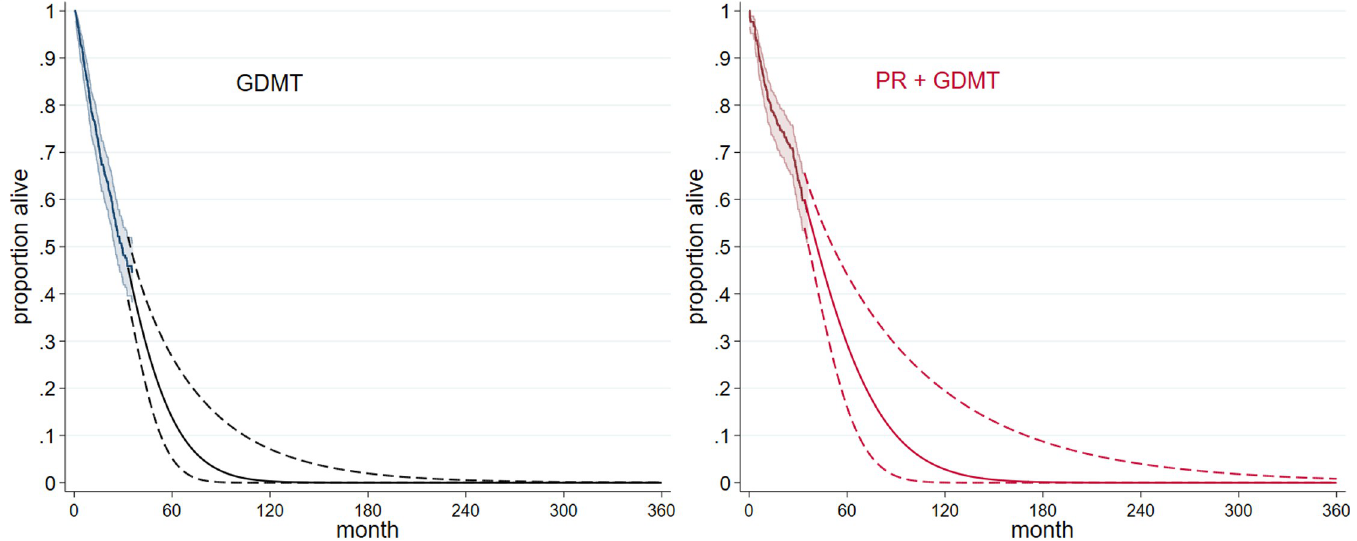
Fig 3. Survival models in CE studies compared to in-trial 3-year survival in COAPT. A 3-year COAPT in-trial survival (red intervention arm, blue GDMT arm) compared to Baron et al. (black dashed) and Cohen et al. (black solid) 2-year based survival models. B 3-year COAPT in-trial survival (red intervention arm, blue GDMT arm) compared to NICE guideline (dashed) and Shore (black solid) survival models. C 3-year COAPT in-trial survival (red intervention arm, blue GDMT arm) compared to Flexible parametric models with differing degrees of freedom (black solid and dashed).